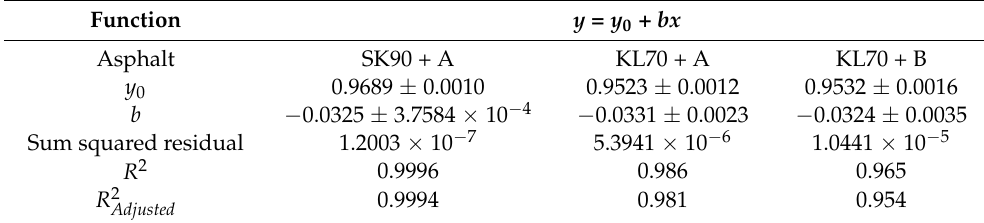
Table 4. Fitting result of the relation between h and effective filler volume fraction.